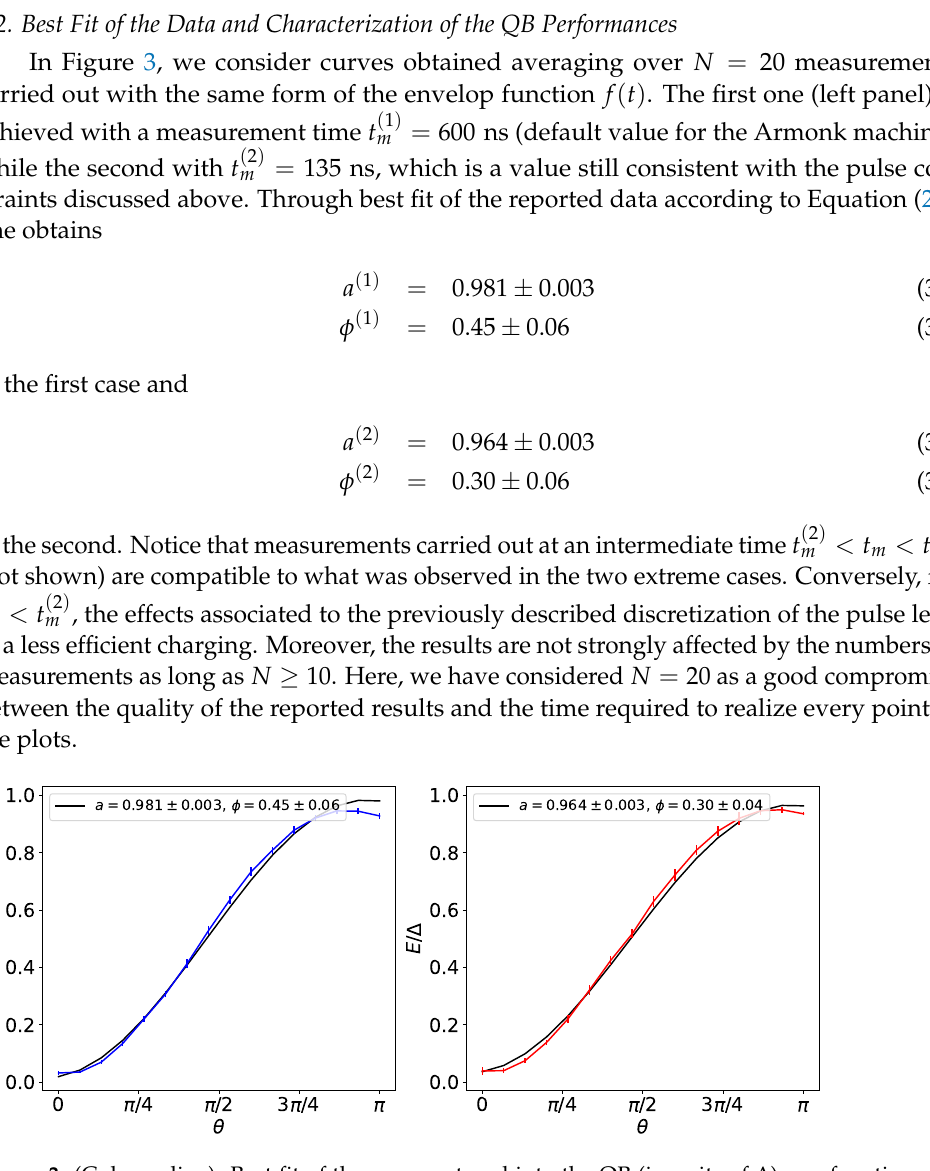
Figure 3. (Color online). Best fit of the energy stored into the QB (in units of ∆ ) as a function of θ (black curves). Data correspond to Gaussian pulses with σ = t m /8, being t m = 600 ns (blue curve in the left panel) and t m = 135 ns (red curve in the right panels). Every point is obtained averaging over 20 different measurements (see Figure 2), and the bars take into account the standard error associated to this